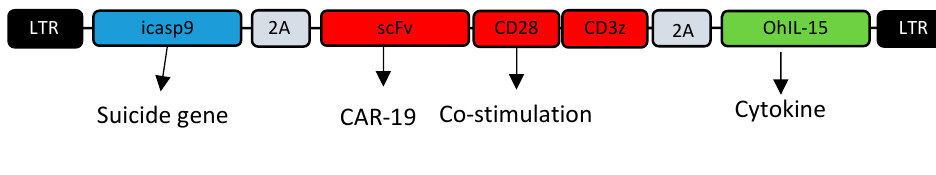
Figure 3. CAR-NK cells derived from umbilical cord blood: The CAR-NK cells’ construction, described by Rezvani et al. [45] from the MD Anderson Center, was achieved from a classical CD19 CAR with a costimulatory CD28 domain, to which a suicide gene and an IL-15 gene were added.